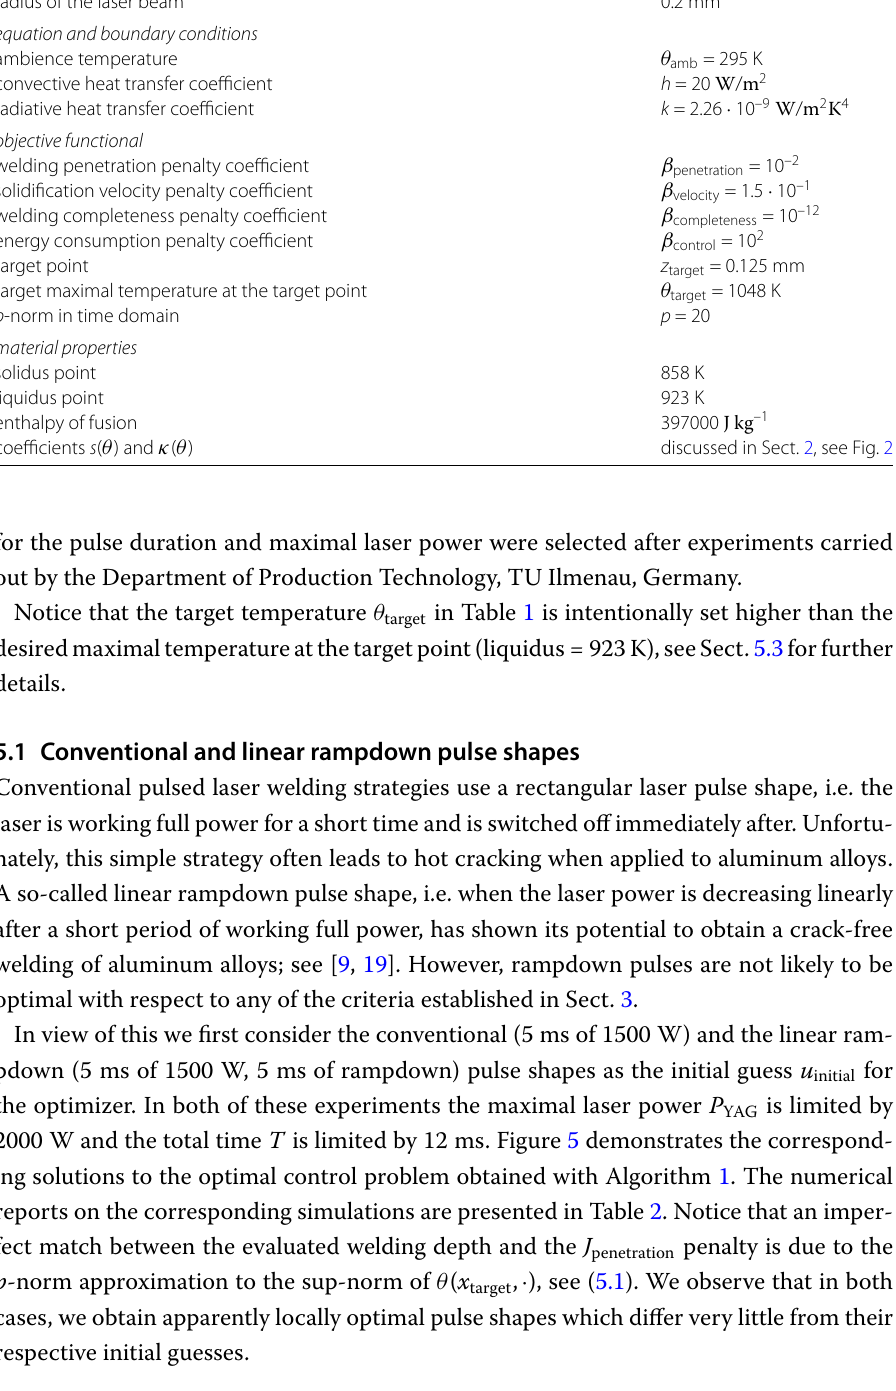
Table 1 Parameters of the numerical experiments spacedomain radius of the cylinder